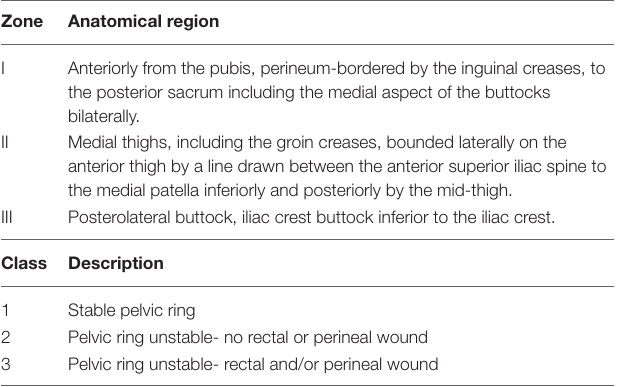
TABLE 1 | Classification systems for open pelvic